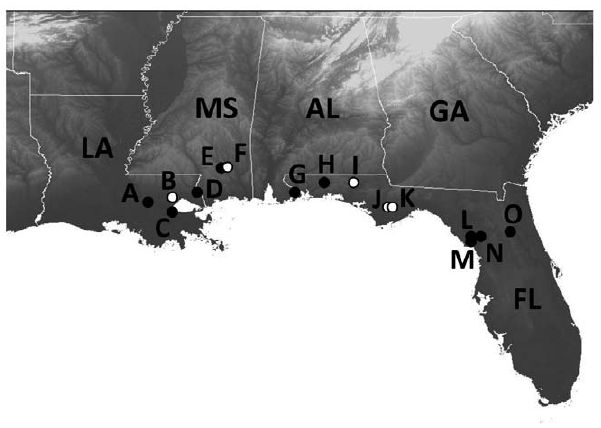
Figure 1. Map of southeastern United States showing collec- tion localities. Filled circles indicate those sites where Bd was detected and open circles indicate those sites where Bd was not detected. Background shading indicates elevation (lighter = higher elevation).